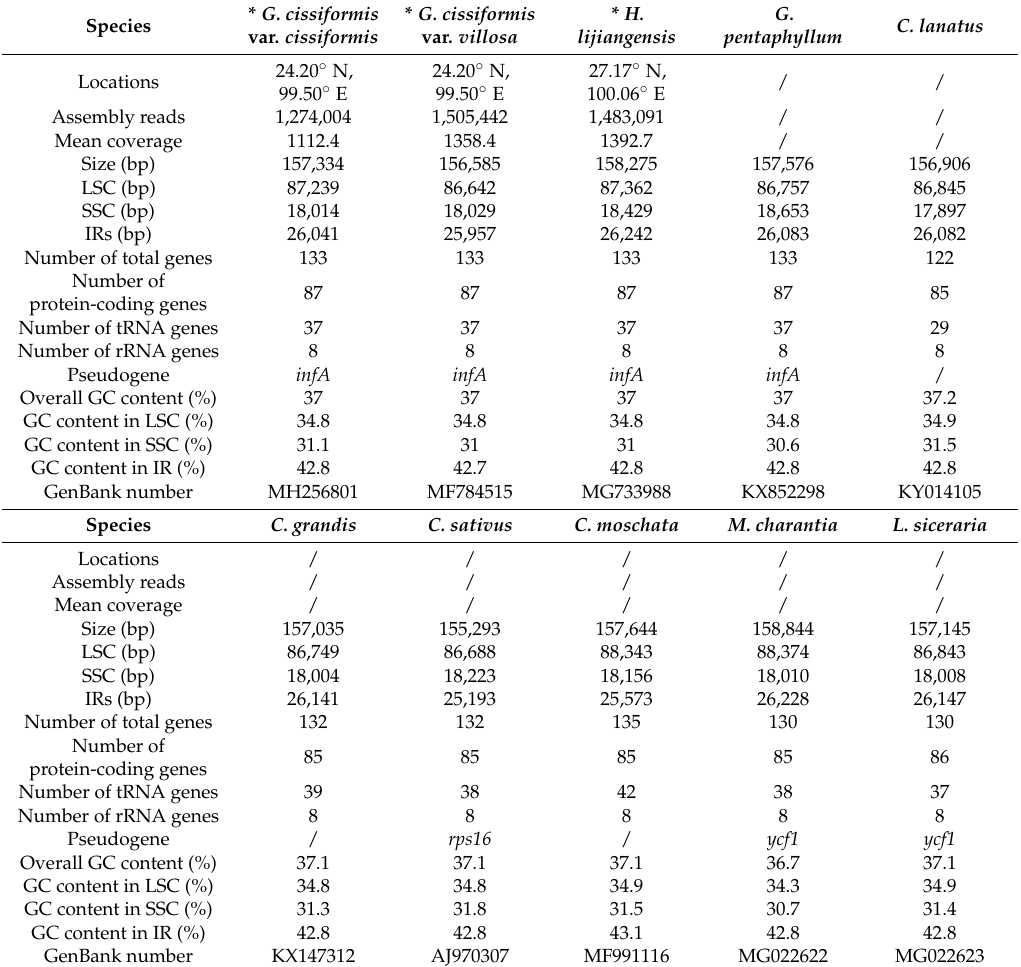
Table 1. Genome features of the chloroplast genomes of ten Cucurbitaceae species.